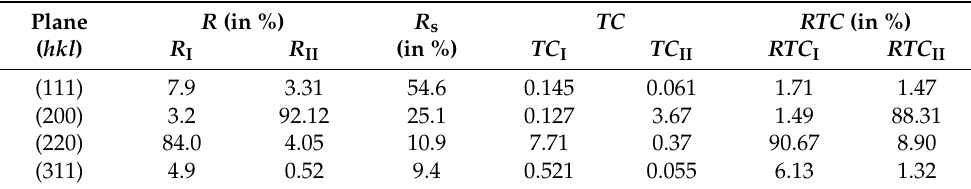
Table 2. Texture calculations for the Cu coatings obtained from the electrolytes without ( electrolyte I ) and with additives ( electrolyte II ). ( electrolyte I —I; electrolyte II —II; s—Cu